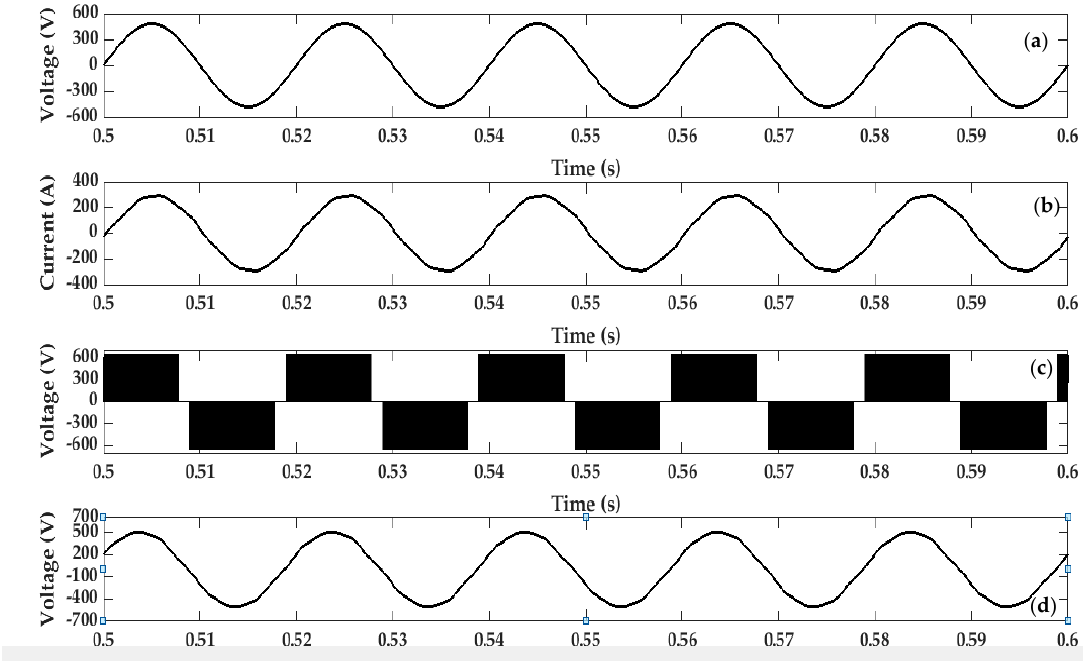
Figure 10. Phase A waveforms of AC fast charging voltage and current: ( a ) input voltage, ( b ) input current, ( c ) voltage before LC filter ( d ) voltage after LC filter.